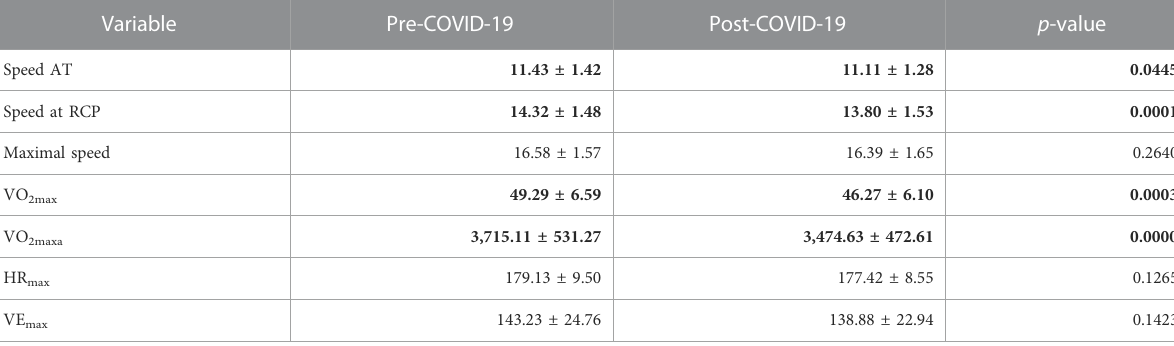
TABLE 4 Differences between pre- and post- COVID-19 CPET for treadmill. Variable